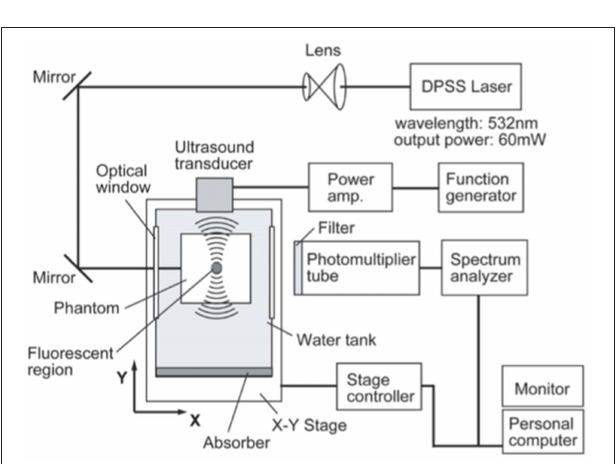
FIGURE 2 | Typical ultrasound-modulated fluorescence imaging system (Kobayashi et al., 2006). Reproduced with permission. Copyright 2006 © API